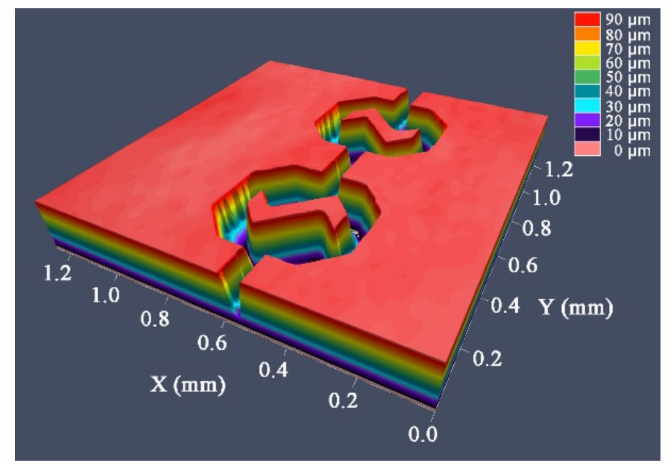
Figure 2. Characterization of the micro-structure of Si master by confocal